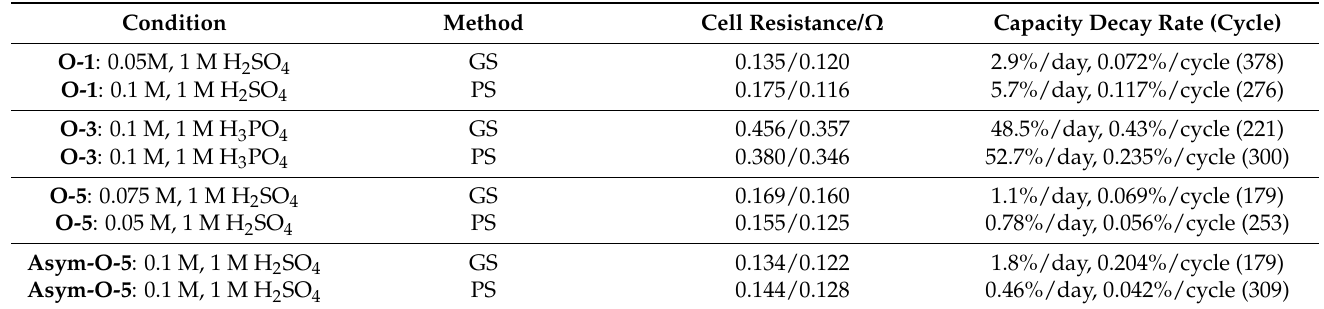
Figure 3. ( a ) Schematic representation of the proposed decomposition pathway of O-3 ; ( b ) schematic representation of the chemical structure of TMHQ. Table 1. Symmetric cell cycling tests of O-1 , O-3 , O-5 and asym-O-5, using the PS and GS cycling methods.